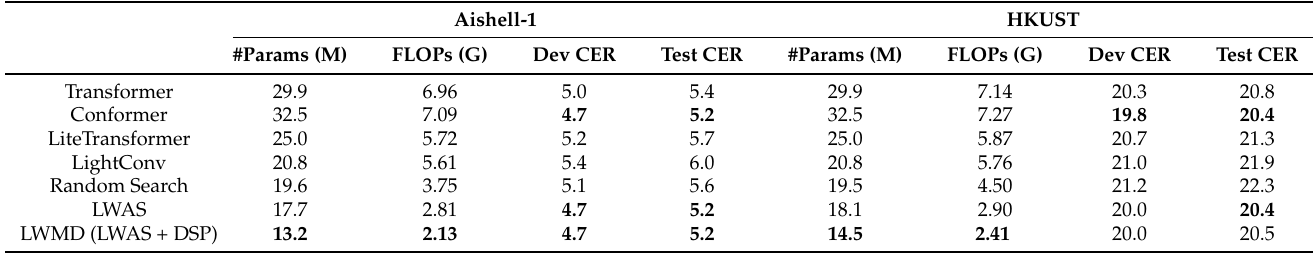
Table 2. Experiment results under the AED framework. FLOPs refer the averages of processing one-second speech. The best results on each framework are in boldface.